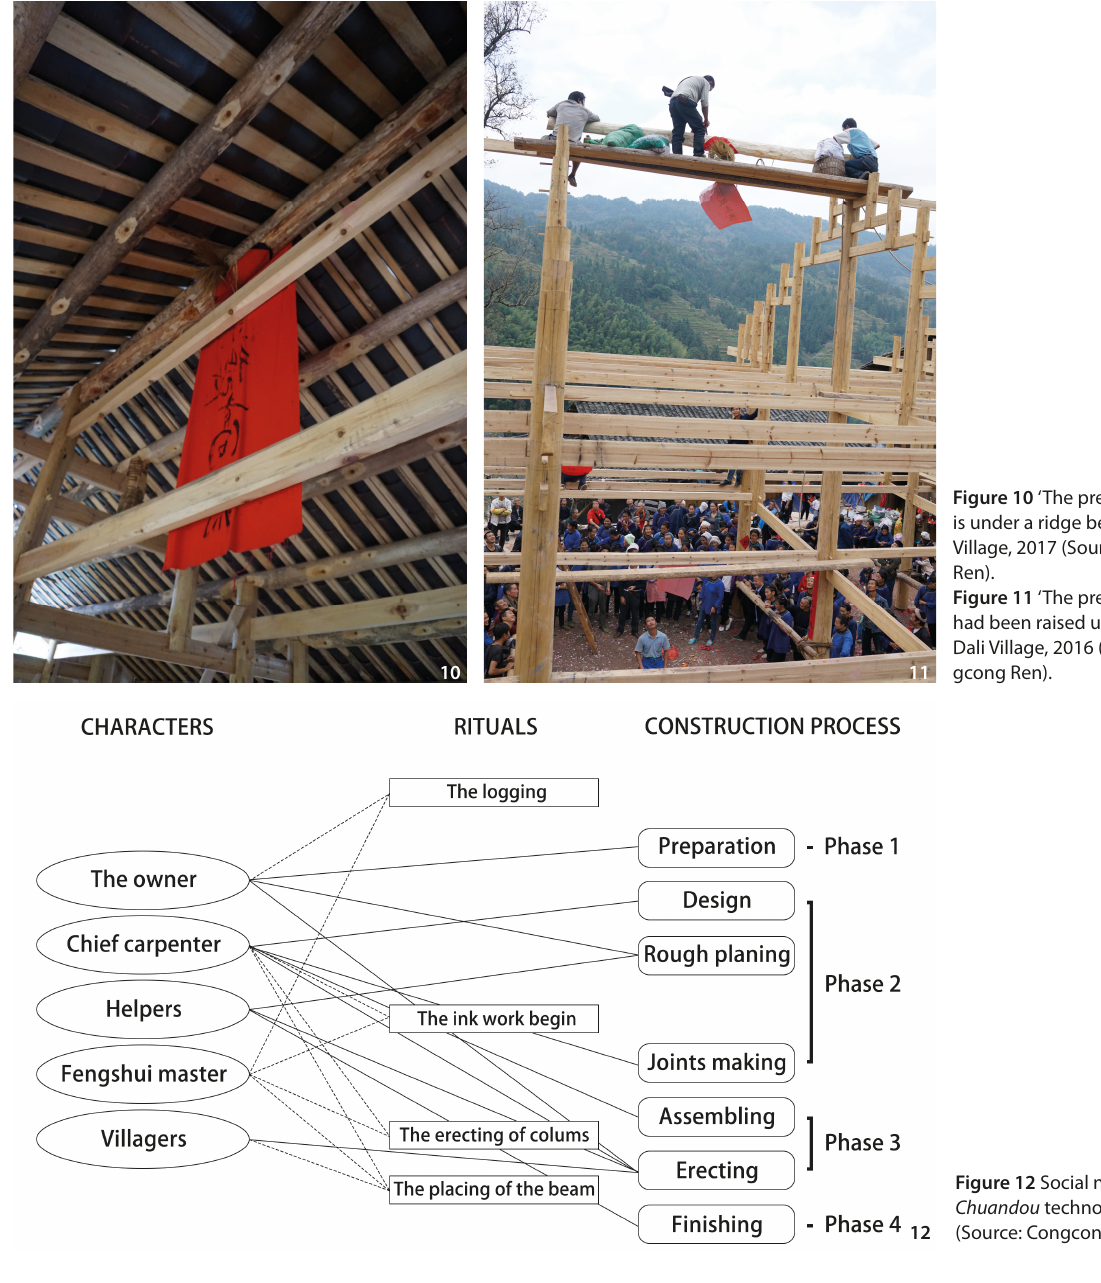
Figure 10 ‘The precious beam’ is under a ridge beam. Zaidang Village, 2017 (Source: Congcong Ren). Figure 11 ‘The precious beam’ had been raised up to the ridge. Dali Village, 2016 (Source: Con- gcong Ren).